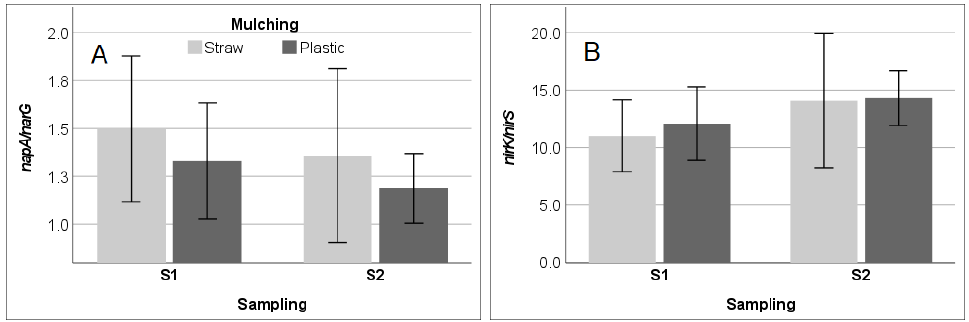
Figure 4. Relative ratios of the genes involved in denitrification potential of the studied plots, differentiated by mulching system (straw vs. plastic mulching) and sampling day (S1 & S2). ( A ): napA:narG , and ( B ): nirK:nirS Table 2. Correlation matrix between soil enzyme activities and soil physicochemical (SWC, pH, DOC, C:N and MBC:SOC) and microbial parameters (Total PLFAs, F:B and gr+:gr − ratios). Signifi- cant correlations in bold print.